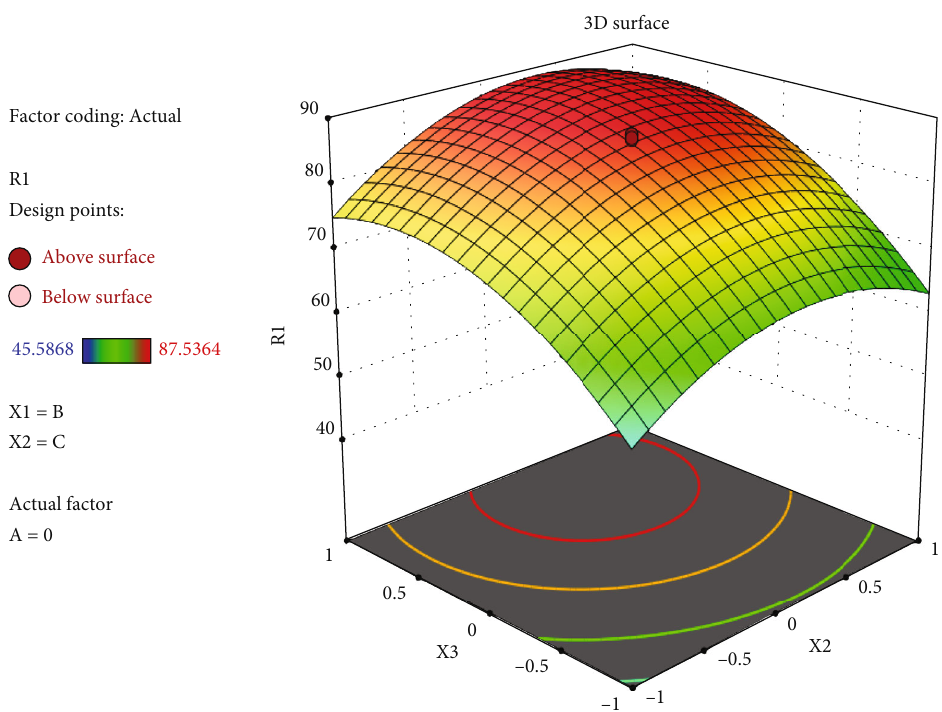
Figure 4: RSM plot: e ff ect of time ( X